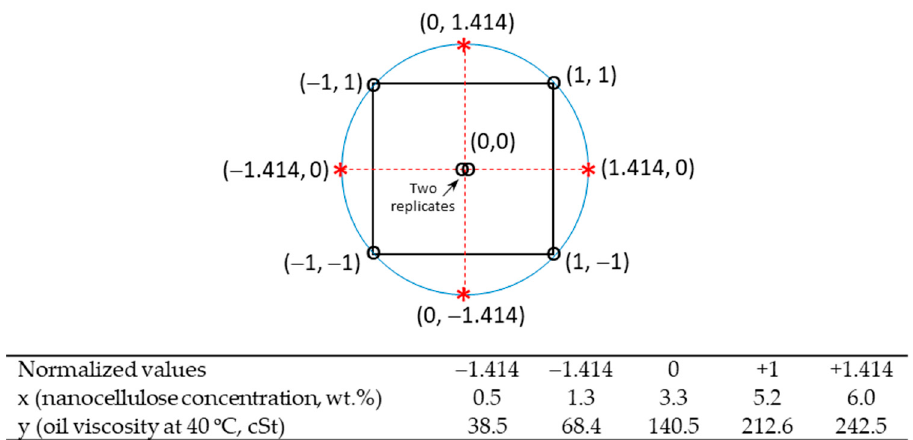
Figure 1. Box–Wilson Central Composite design based on a circumscribed central rotatable matrix, showing the correspondence between normalized values (levels) and actual values for the two variables (factors) of interest (nanocellulose concentration, x, and oil viscosity, y).